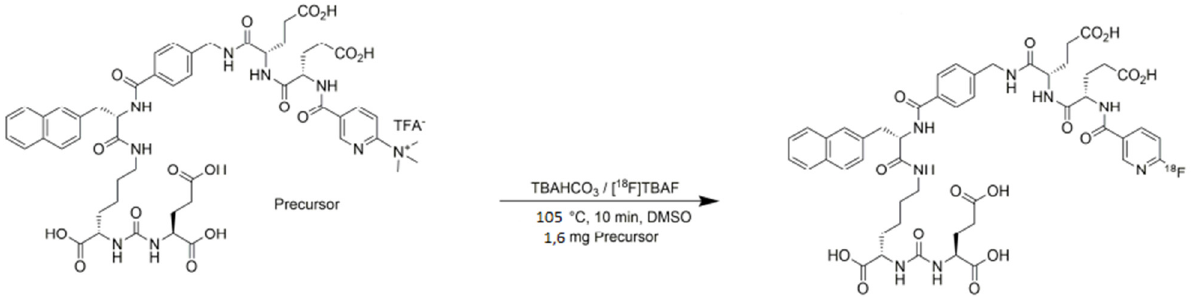
Figure 1. Radiosynthesis route of [ 18 F]F-PSMA-1007.